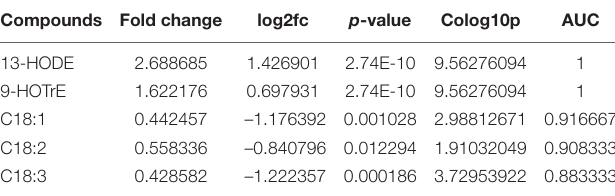
TABLE 7 | Statistically significant compounds (OH vs. LH). p -Value < 0.05 (Wilcoxon-Mann-Whitney test). Fold change ≥ 1.5 or ≤ 1/1.5. AUC (area under the curve) value of predictors selected by machine learning analysis (see Supplementary Figures 18–20 A–C and Supplementary Tables 1, 7 ).